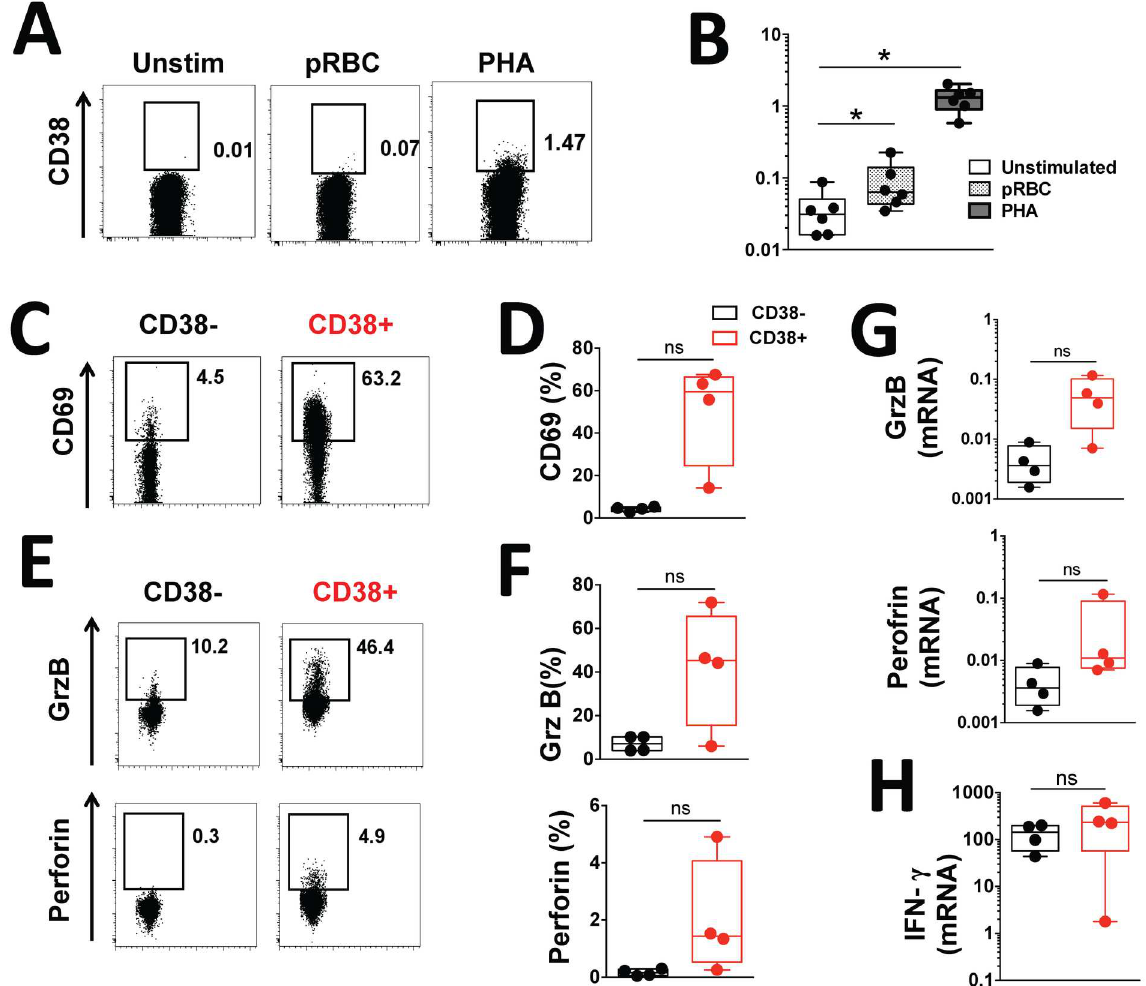
Fig 7. CD38 - CD4 + T cells can differentiateintoCD38 + CD4 + T cellsupon in vitro stimulation. (A) Representative stainingof one volunteer and (B) the frequencyof CD38 + cells measuredby flow cytometry in CD38 - CD4 + T cells isolatedfromhealthy volunteers and invitro stimulatedwith P . falciparum parasitizedred blood cells extract (pRBC)at 10 6 pRBC/mLor PHA at 5 μ g/mL for seven days. (C-H) CD38 - CD4 + T cells were isolatedfromhealthy volunteers, in vitro stimulated for seven days with 5 μ g/mLPHA and sortedinto CD38 - and CD38 + CD4 + T cells for flow cytometry or gene expression analysis. (C) Representative stainingof one volunteer and (D) the frequencies of CD69 + cells measuredby flow cytometryin CD38 - (black) or CD38 + (red)CD4 + T cells. (E) Representative stainingof one volunteer and (F) the frequenciesof Perforin + and GranzymeB + cells determined by flow cytometry in CD38 - (black) or CD38 + (red)CD4 + T cells. (G) Gene expression of Perforin and GranzymeB measuredby RT-qPCR in CD38 - (black) or CD38 + (red)CD4 + T cells. (H) IFN- γ gene expression measuredby RT-qPCR afterPMA and Ionomycinstimulationof CD38 - (black) or CD38 + (red)CD4 + T cells. Gene expression was normalizedto referencegene RPL13A.Graphs show combined data from(A-B)six and (C-H)four healthy volunteers. Differences between cultureconditions were determined using the non- parametricWilcoxon test;box and whisker plots indicatemedian,interquartilerange and min-max; * , p < 0.05ns, p >